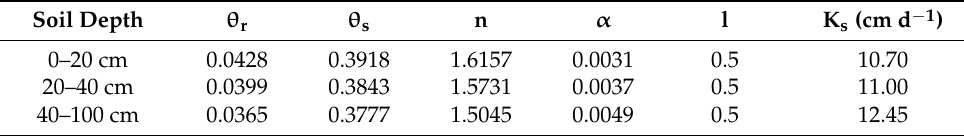
Table 4. Hydraulic parameters of simulated